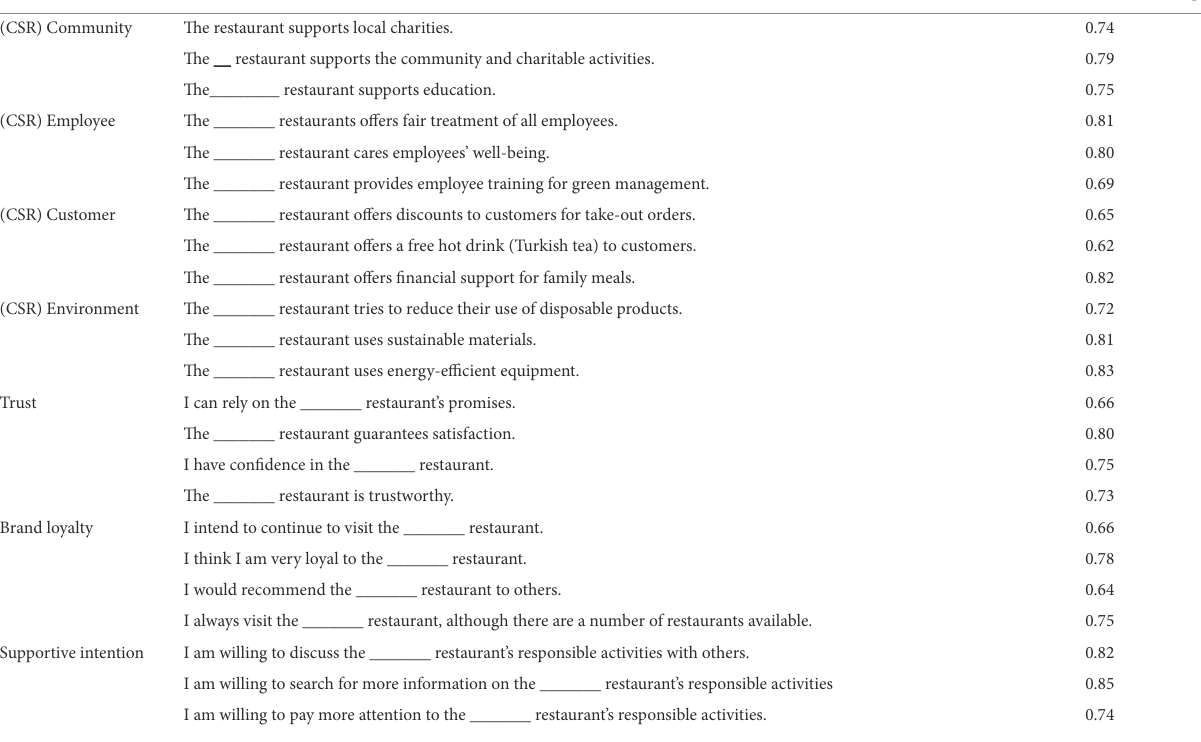
TABLE 2 The measurement items and CFA